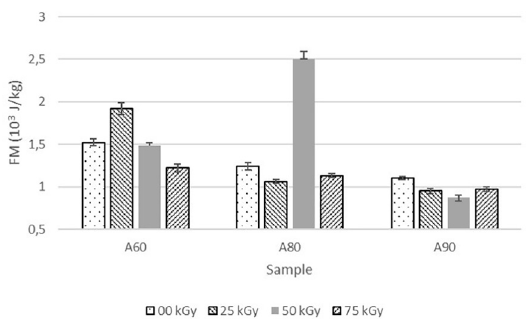
Figure 2. Merit factor of composites with 60%, 80% and 90% alumina concentration, non-irradiated and irradiated with 25 kGy, 50 kGy and 75 kGy. Table 2. Gel content of UHMWPE, non-irradiated and gamma irradiated with doses of 25 kGy, 50 kGy and 75 kGy.